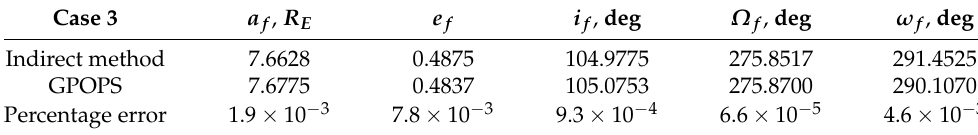
Table 2. Comparison of the solutions solved by GPOPS and the indirect method for Case 3. Case